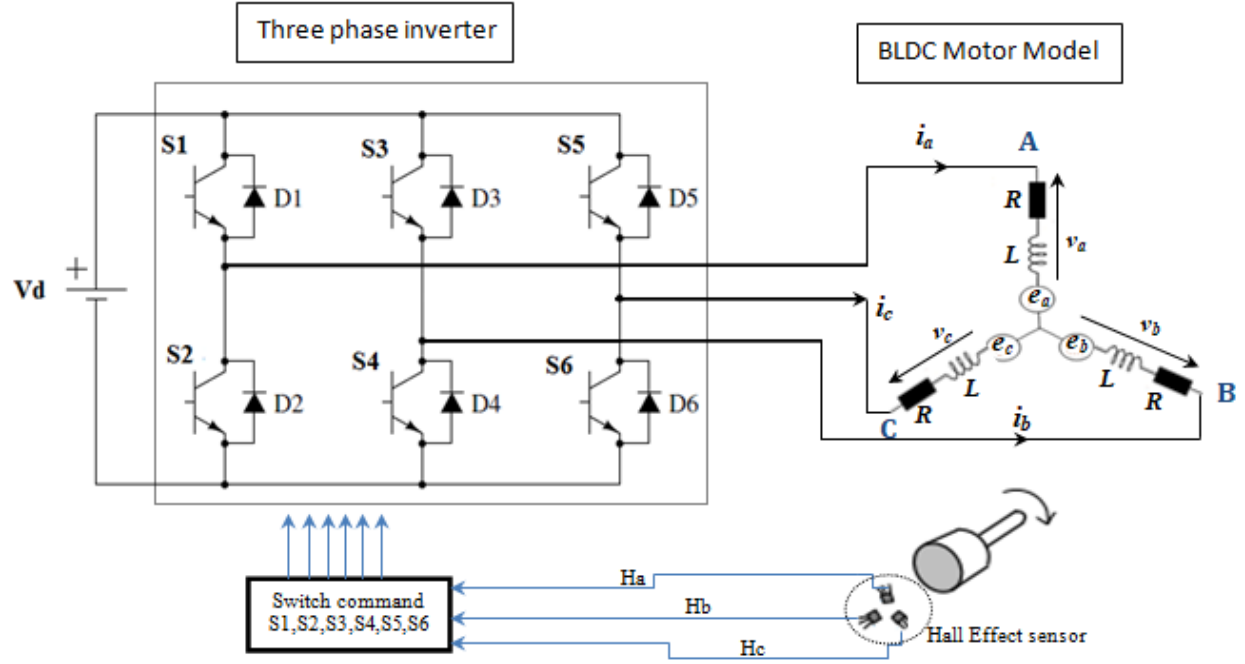
Figure 6. Drive model of a BLDC motor [43–47].